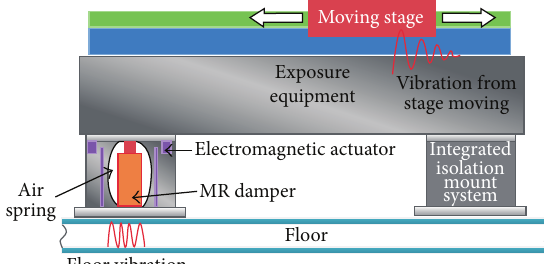
Figure 8: Configuration of integrated isolation